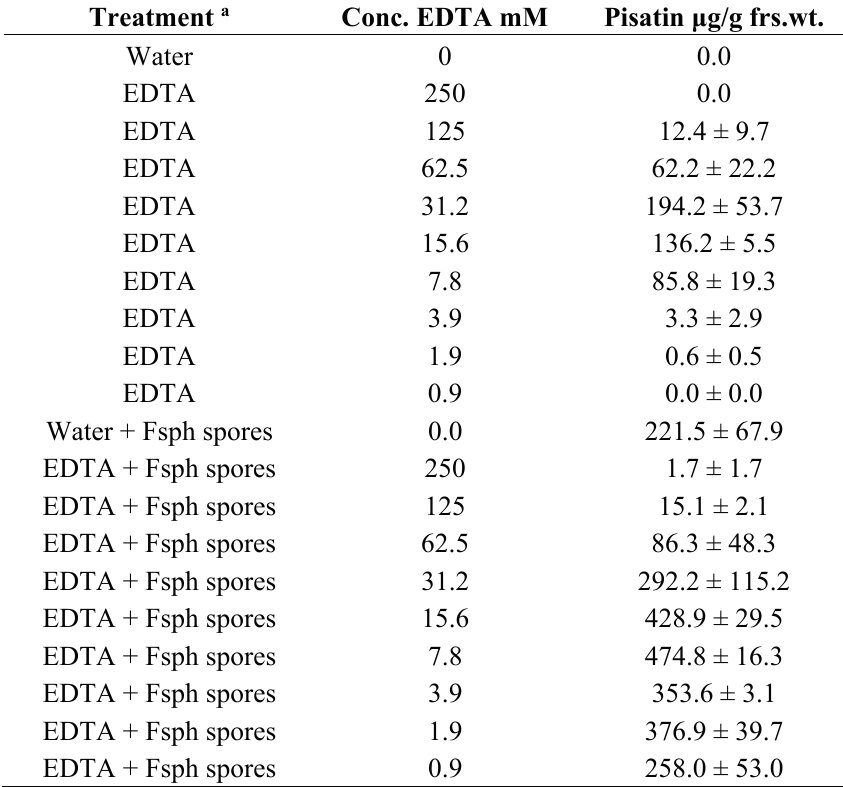
Table 1. The effect of a broad range of EDTA concentrations on the induction of pisatin accumulations in pea endocarp tissue in the presence and absence of Fusarium solani f. sp. phaseoli (Fsph) a pathogen of